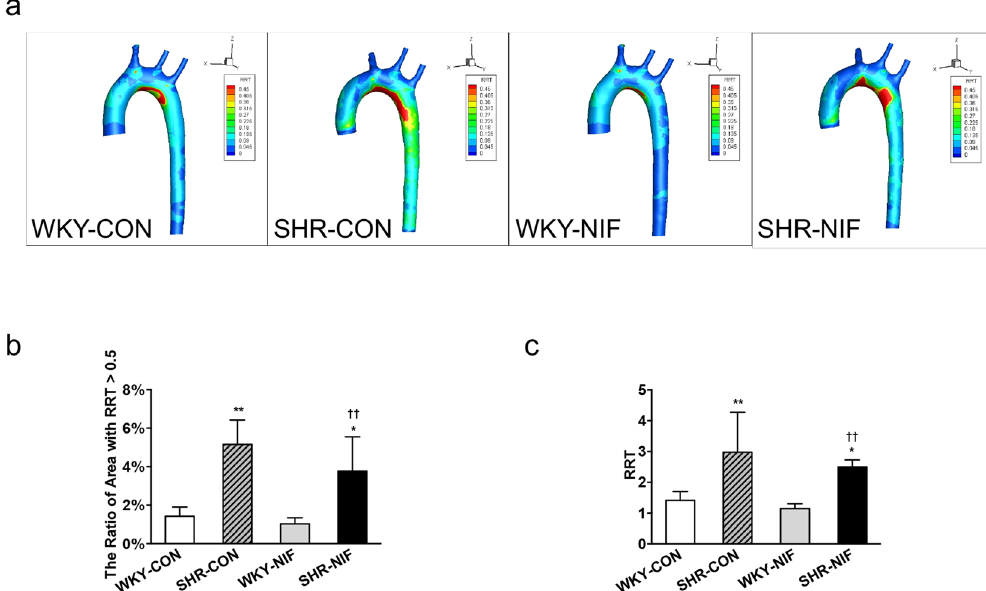
Figure 2. The RRT was obviously increased in antihypertensive-treated SHRs compared with WKYs. ( a ) Distribution of the RRT averaged over a cardiac cycle derived from aorta CFD models in SHRs and WKYs. The RRT scale ranges from 0 (dark blue) to 0.5 (red). ( b ) The ratio of the area with an RRT > 0.5 of the whole aorta model and ( c ) the RRT values in a region near the inner wall of the aortic arch were analysed. Values are presented as the mean ± SD. (n = 6). * P < 0.05, ** P < 0.01, vs WKY-CON. †† P < 0.01, vs WKY-NIF. CON, control; NIF,